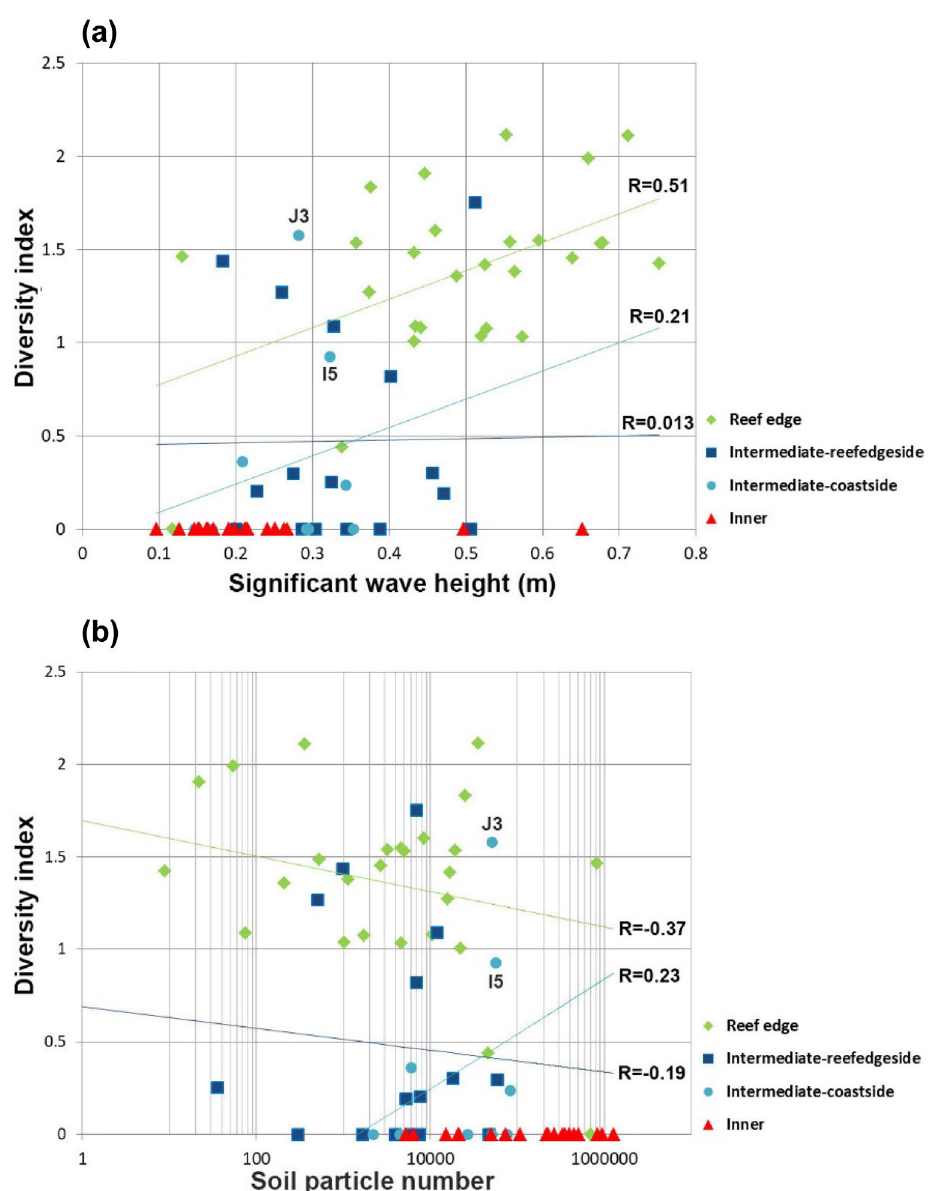
Fig. 3 a Relationship between the diversity index and significant wave height (m) in Sakiyama Bay. The significant wave height is shown by values in winter, which is much more significant than in summer. The linear fits are calculated by the parts. R values show the correlation coefficients to the corresponding lines. The calculation details were described by Shimokawa et al. (2014a, 2016). b Relationship between the diversity index and the number of soil particles in Sakiyama Bay. The numbers show averaged values for the number of soil particles virtually released from river mouths and arrived at the sea bottom in a day in numerical simulations. The calculation details were described by Shimokawa et al.